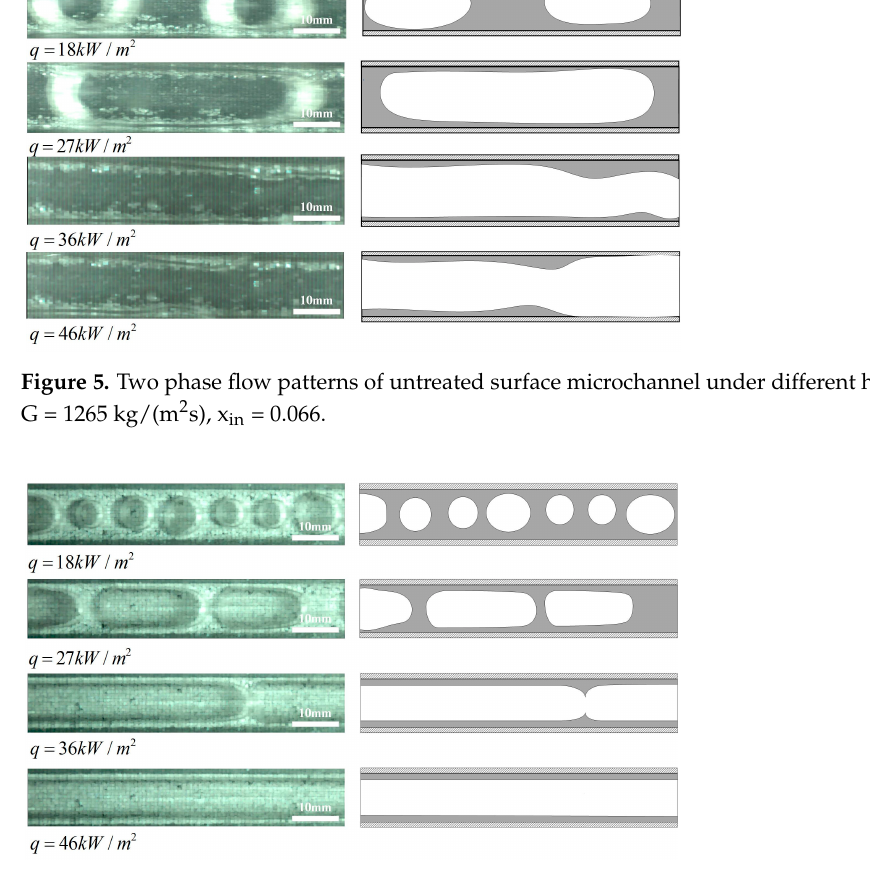
Figure 6. Two phase flow patterns of super-hydrophilic microchannel under different heat fluxes for G = 1265 kg/(m 2 s), x in = 0.066.